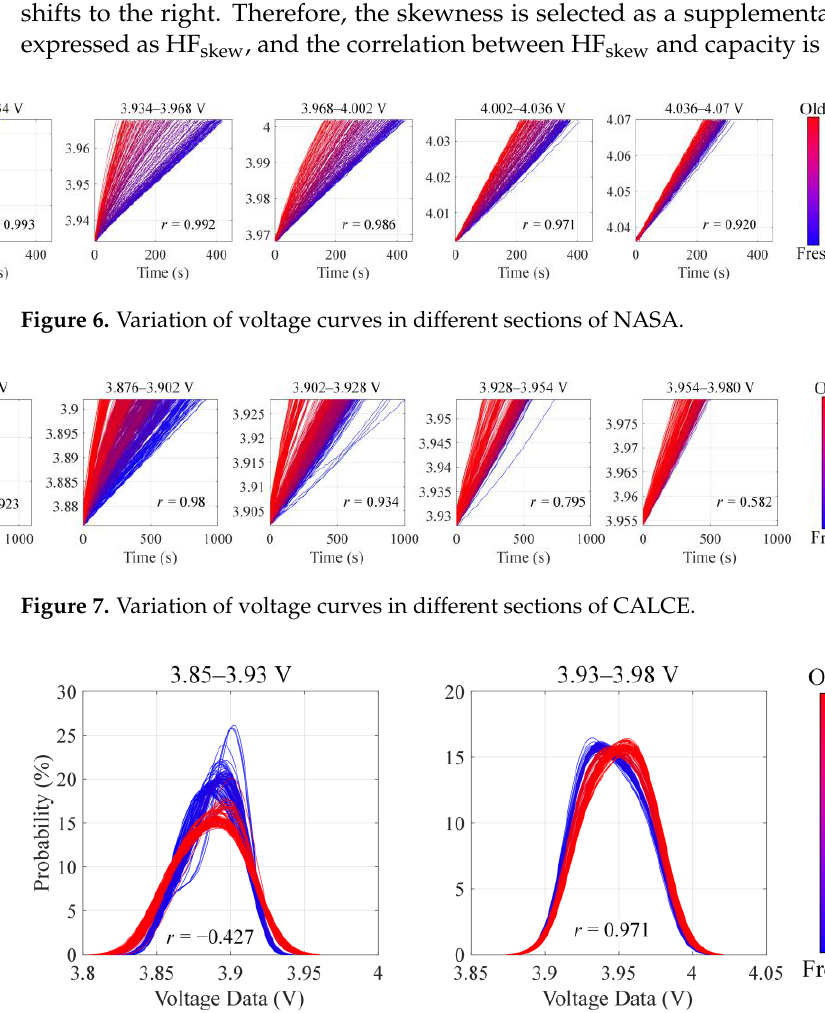
Figure 9. The correlation between capacity and skewness of NASA.